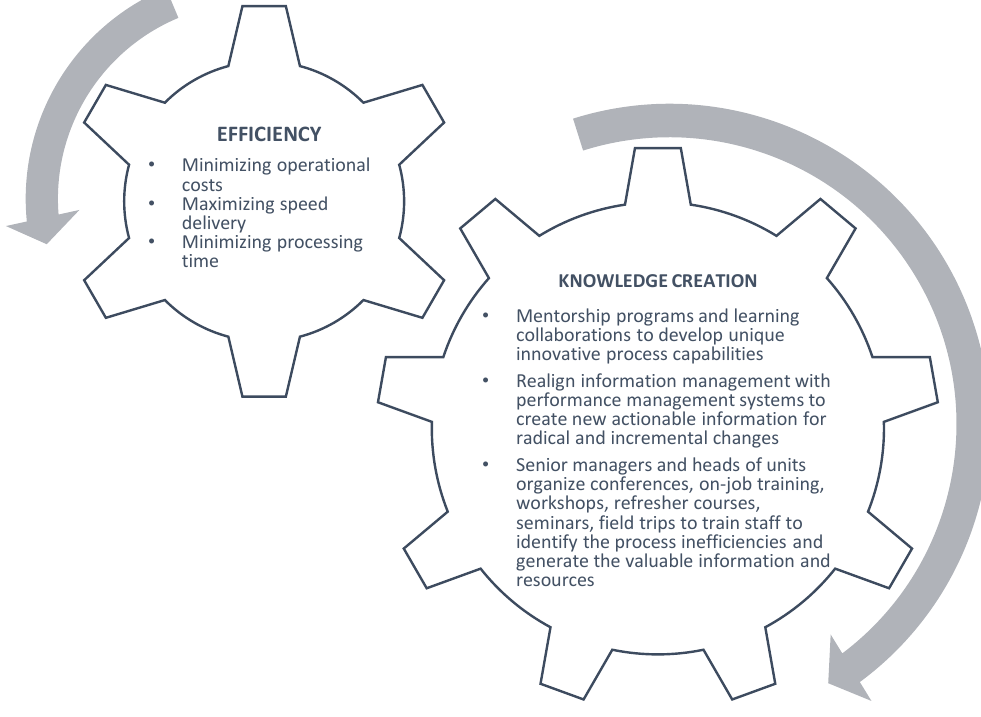
Figure 1. Improving efficiency of microfinance institutions through knowledge